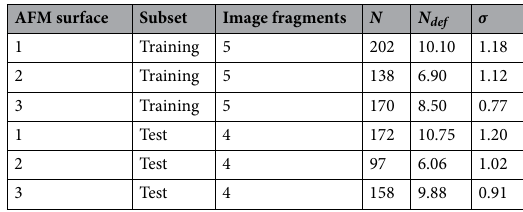
Table 1. AFM image sets used for defect detection model training and